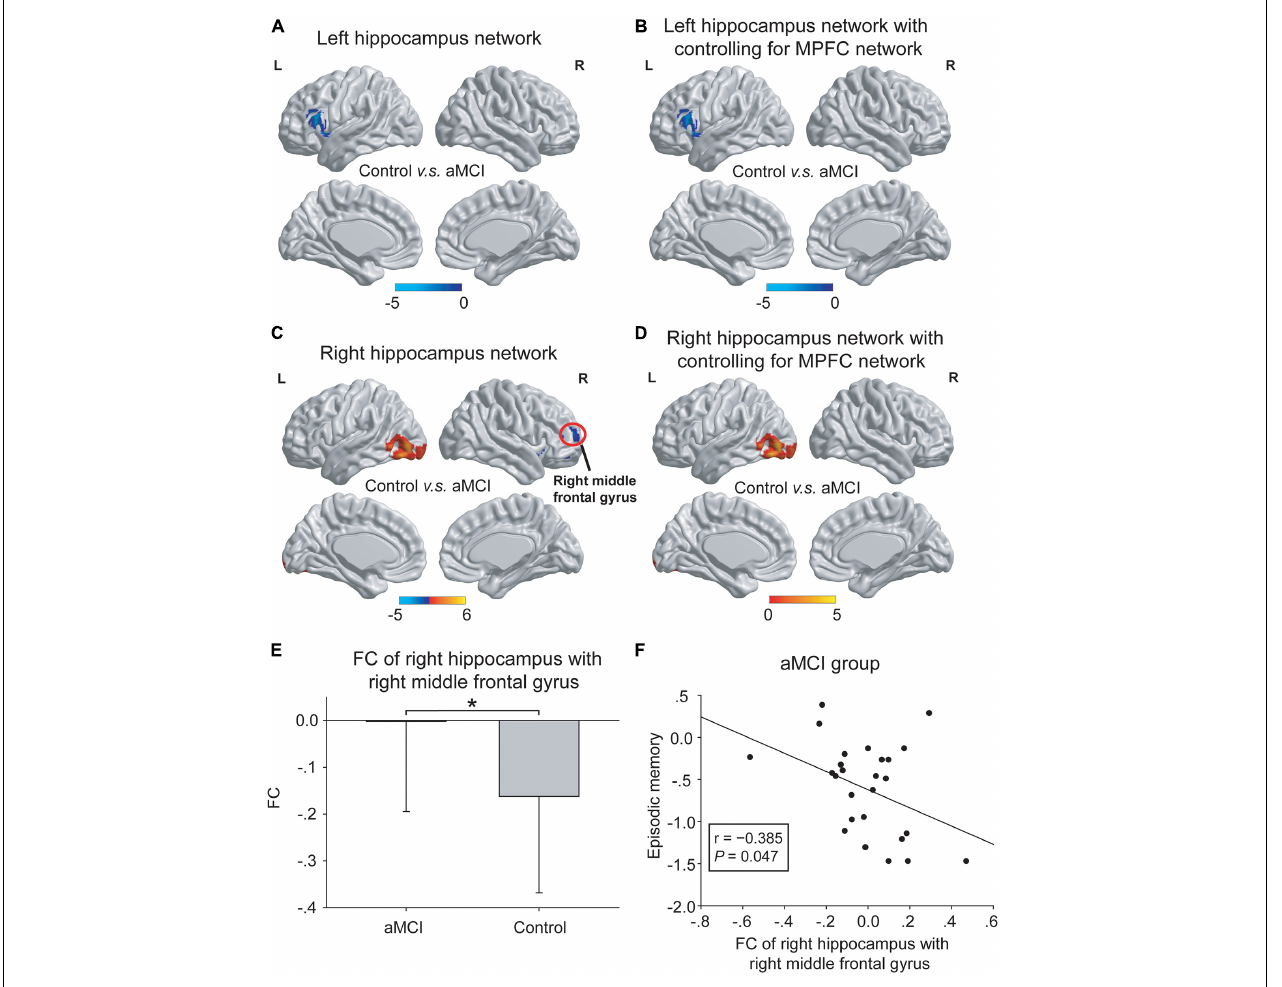
FIGURE 4 | The differences in hippocampal networks between the control group and the aMCI group. (A,B) In the left hippocampal network, compared with the control group, the aMCI group showed increased FC in the left frontal cortex (blue regions) both with and without controlling for the MPFC network. No significant influence of the MPFC network onto the left hippocampal network was shown. (C–E) In the right hippocampal network, compared with the control group, the aMCI group showed decreased FC in the left occipital cortex (red regions) both with and without controlling for the MPFC network. Notably, the aMCI group showed increased FC in the right middle frontal gyrus [red circle in panel (C) ] only without controlling for the MPFC network [also shown in panel (E) ]. The statistical thresholds were set at a corrected P < 0.01, which was determined by a Monte Carlo simulation. The color bars are presented with t values. (F) The increased FC of the right hippocampus with the right middle frontal gyrus was negatively associated with episodic memory scales in the aMCI group. The above FC value in each significant cluster was the averaged FC strength in each cluster, and the error bars in panel (E) represent standard deviations of FC values in each group. * P < 0.05. L, left; R, right; FC, functional connectivity; MPFC, medial prefrontal